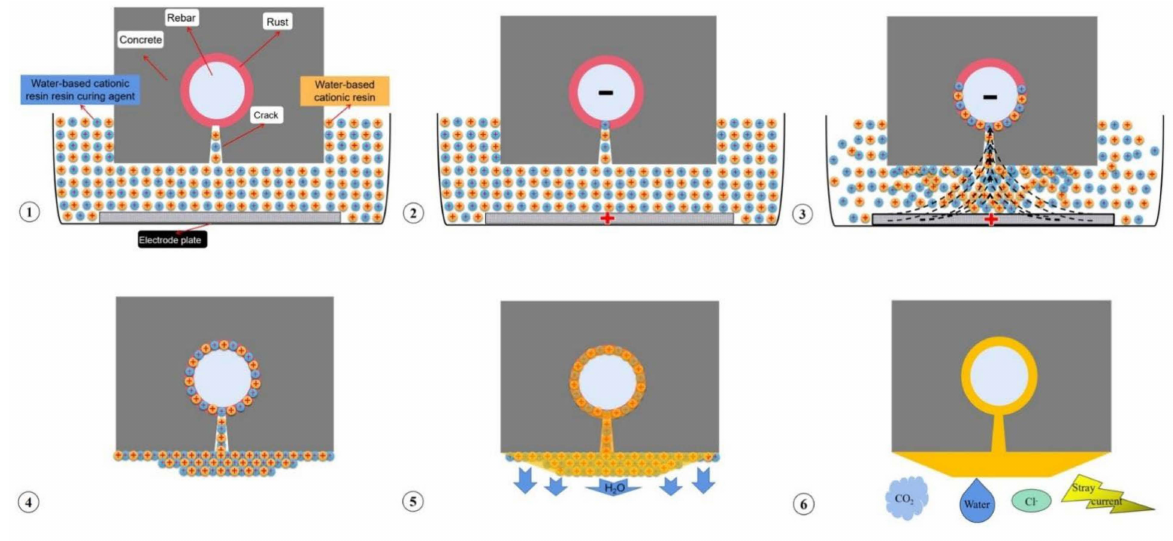
Figure 16. Schematic diagram of electrophoretic deposition repair